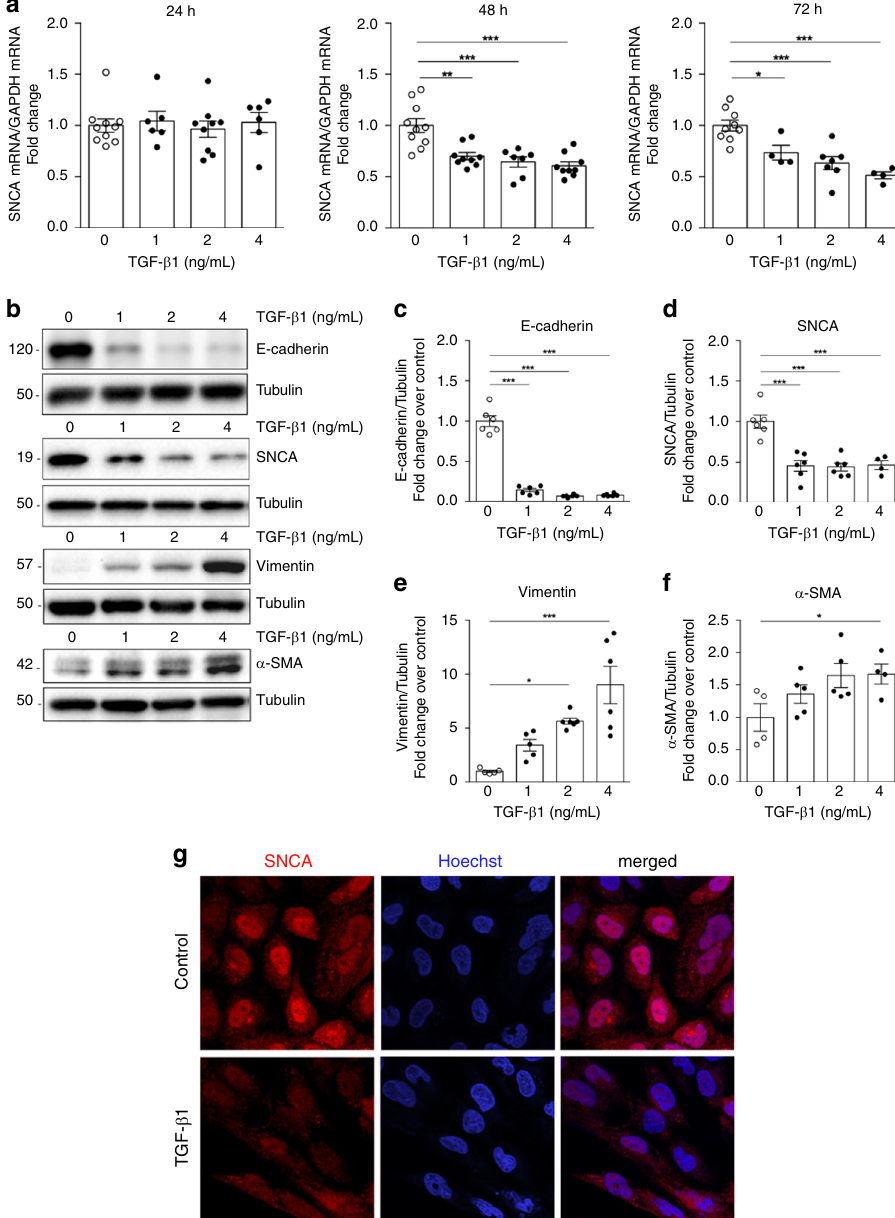
Fig. 1 TGF- β 1 leads to a decrease of SNCA expression in HK-2 in vitro. Human renal proximal tubular epithelial (HK-2) cells were incubated in serum-free medium (control) or TGF- β 1 for 24 h ( a ), 48 h ( a ) and 72 hours ( a , b – f ). a Total mRNA was extracted from HK-2 cells and mRNA levels of SNCA were determined by quantitative real-time PCR and normalized to GAPDH. Data are presented as mean ± SEM of at least n = 3 independent experiments. b Cell lysates were immunoblotted with antibodies against E-cadherin, SNCA, vimentin and α -SMA. The same samples were reprobed with antibodies against tubulin to ensure equal loading. Representative Western blots ( b ) and quantitative densitometric analysis ( c – f ) show decrease of E-cadherin and SNCA expression and an increase of vimentin and α -SMA expression in HK-2 cells treated with TGF- β 1 for 72 h. Data are presented as mean ± SEM of at least n = 2 independent experiments. g Immuno fl uorescence staining for the distribution of SNCA in HK-2 cells after incubation with TGF- β 1 for 72 h. Scale bar represents 20 µ m. * p < 0.05, ** p < 0.01, *** p < 0.001. The p -value by one-way ANOVA. Source data are provided as a Source Data fi